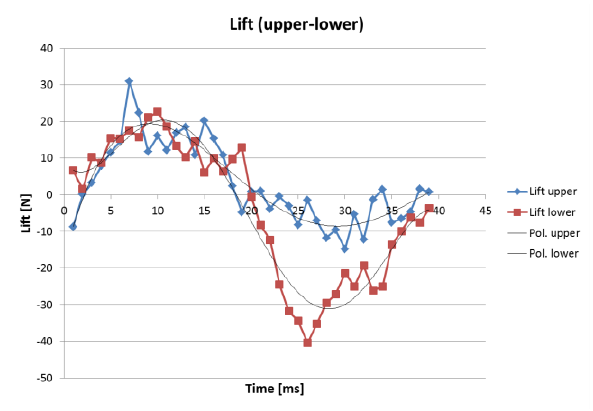
Fig. 12. Lift force divided for upper and lower sides, Ma =